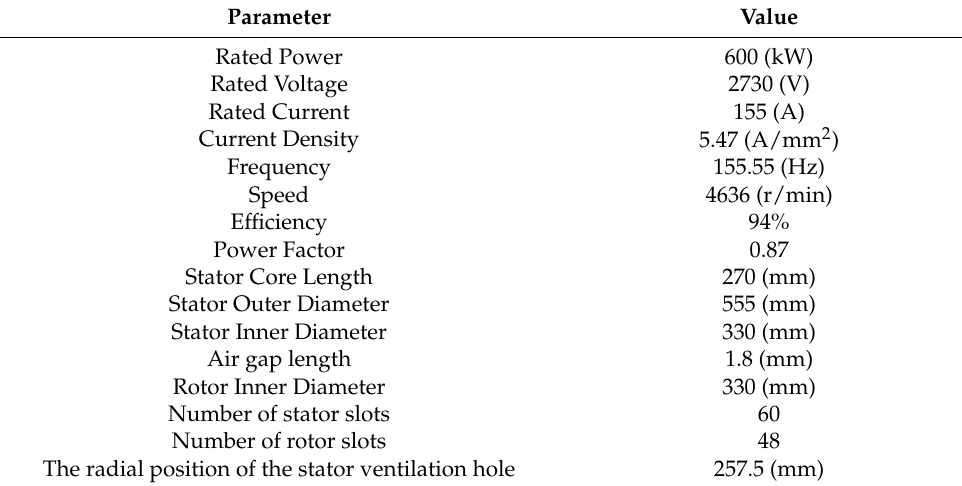
Table 1. Parameter of induction motor.